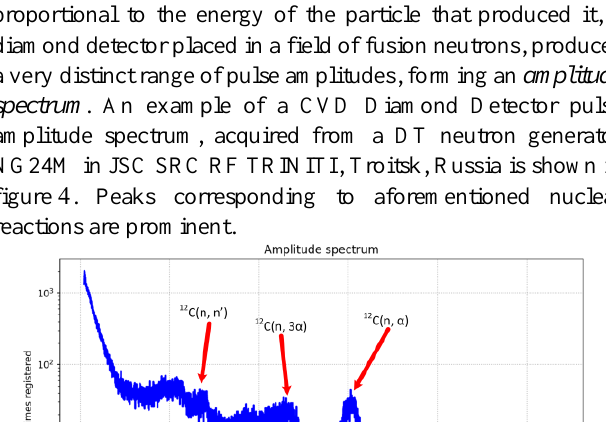
Fig. 4. CVD Diamond Detector pulse amplitude spectrum from an experiment at NG24M (x-axis values are in ADC